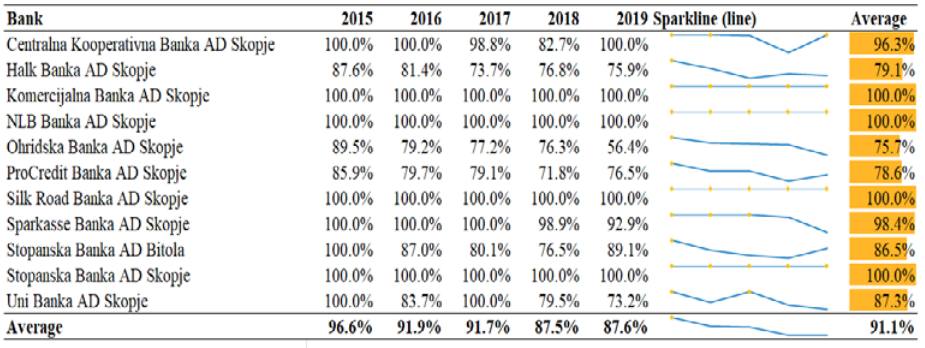
Figure 1. Macedonian commercial banking efficiency